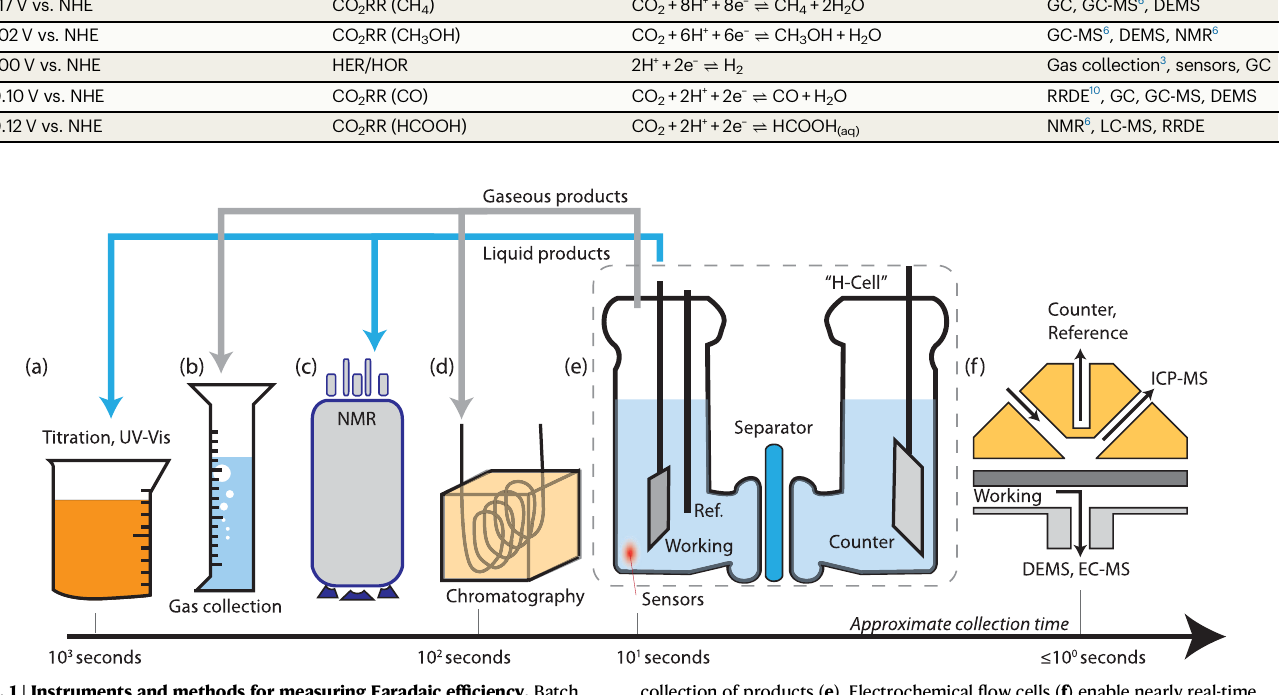
Fig. 1 | Instruments and methods for measuring Faradaic ef fi ciency. Batch